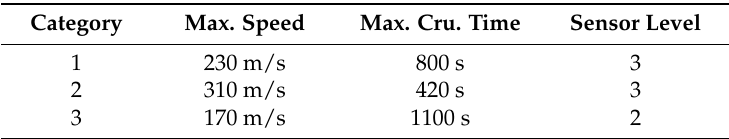
Table 4. Parameters of UAVs.